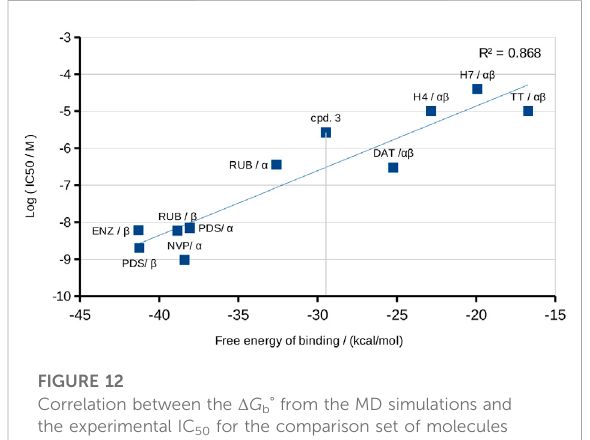
FIGURE 12 Correlation between the Δ G b ° from the MD simulations and the experimental IC 50 for the comparison set of molecules (references in Table